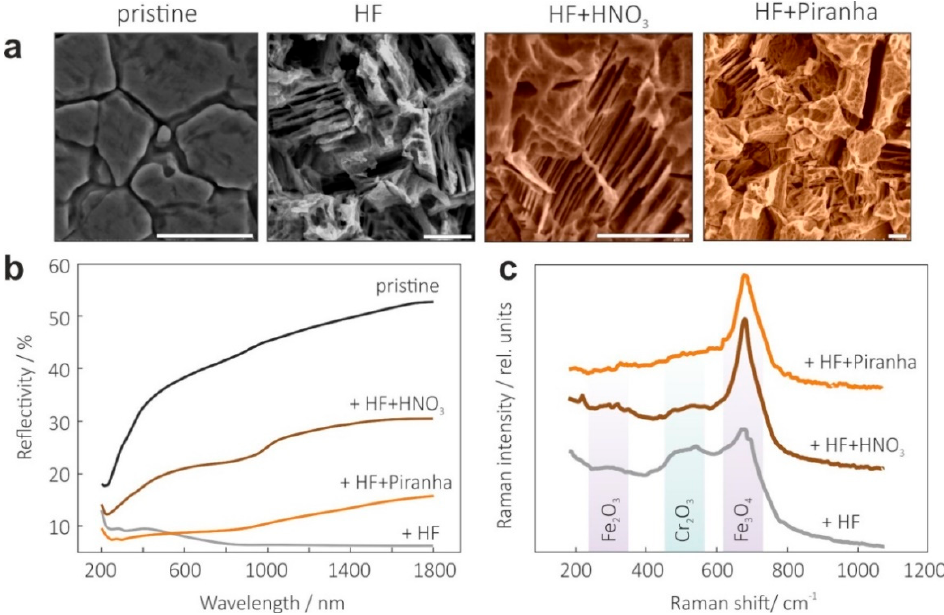
Figure 2. Summary of acid-induced texturing and stabilization on SS surface. ( a ) Evolution of surface morphology after different treatments shown in a series of top-view SEM images. Scale bar indicates 10 µm. ( b ) Optical reflection spectra of pristine SS and those treated under different conditions. ( c ) Probing the changes in surface composition of the SS samples treated under different acid solutions with Raman spectroscopy at 473 nm pump.